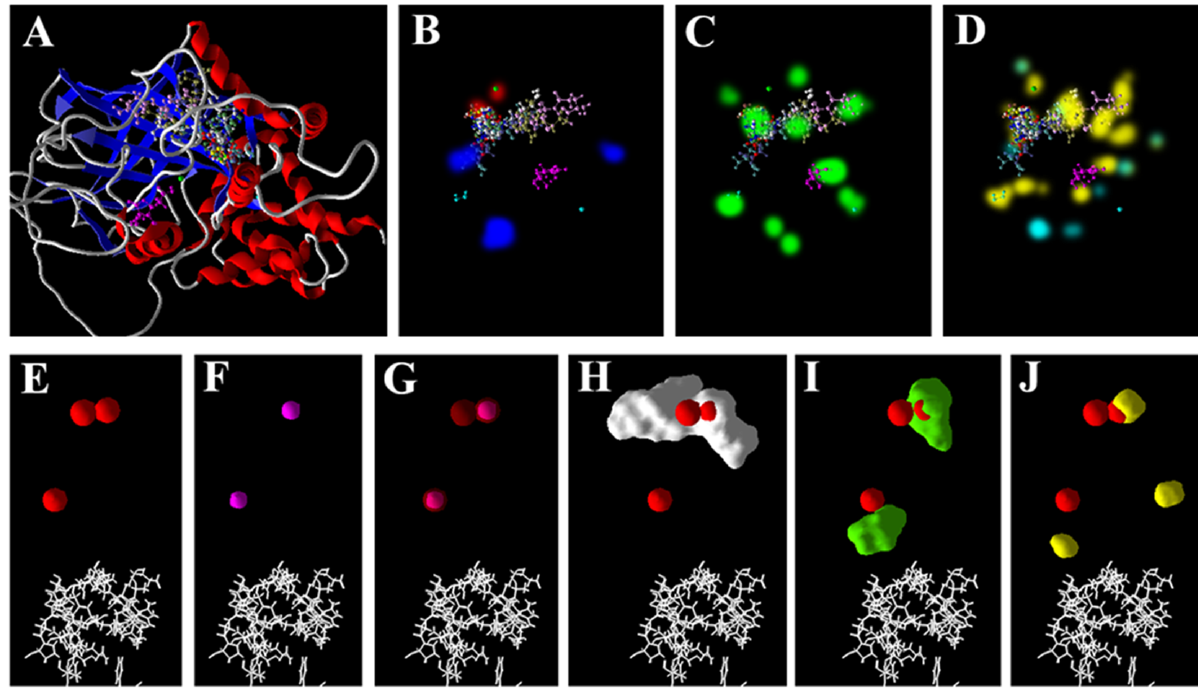
Figure 2. Poses and interactions of ligands and catalase: ( A ) Docked poses of all the ligands. The surface of the receptor favors ( B ) electrostatic, ( C ) stearic and ( D ) hydrogen bond interactions. Electrostatic surface of ( E ) As 3+ , ( F ) Zn 2+ , and overlapping surfaces of ( G ) As 3+ and Zn 2+ , ( H ) As 3+ and GSH, ( I ) As 3+ and AsA, and ( J ) As 3+ and H 2 O 2 . Poses and surfaces were developed using MVD.